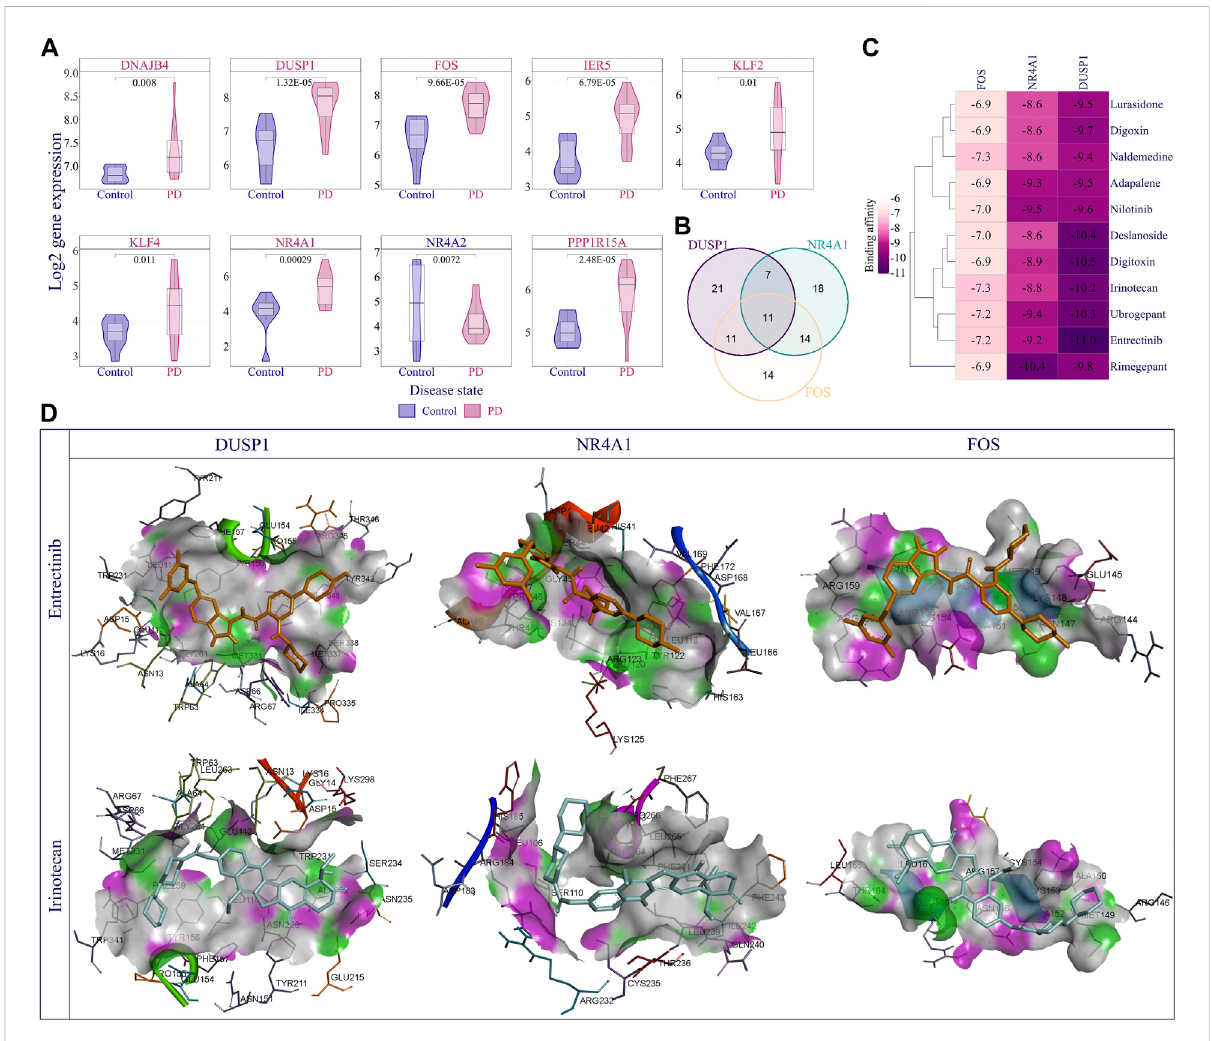
FIGURE 6 Discovery of best inhibitors for TNF- α signaling via NF- κ B pathway. (A) The violin plot demonstrates the distribution of log2 expression of nine dysregulatedgenes(|foldchange| > 1.5and p -value < 0.05)intheTNF- α signaling viaNF- κ BpathwayinthePDcomparedtothecontrolsamples. (B) Venn diagram represents the overlapping top 50 inhibitors between NR4A1, DUSP1, and FOS. Eleven overlapping drugs were obtained for further analysis, including adapalene, Deslanoside, Digitoxin, Digoxin, Entrectinib, Irinotecan, Lurasidone, Naldemedine, Nilotinib, Rimegepant,